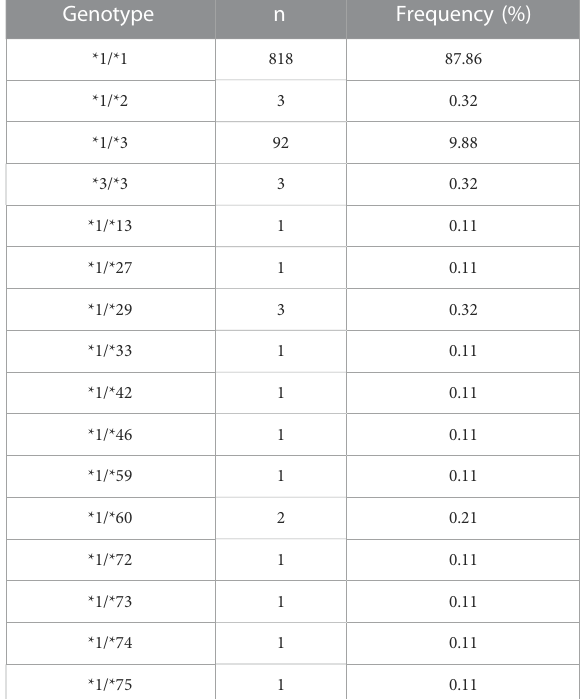
TABLE 3 Genotype frequencies of CYP2C9 allelic variants in Han Chinese populations population.